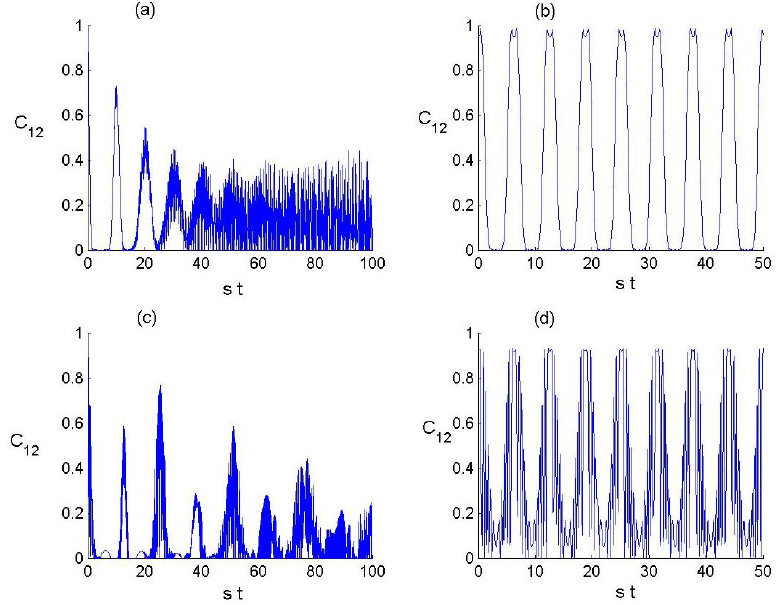
Figure 3. Time evolution of the TQS entanglement denoted by C 12 . Panels ( a , b ) correspond to the case of absence of the PDP effect (i.e., λ = 0 ) for constant ( D ( t ) = s ) and t-dc ( D ( t ) = s sin ( t )) , respectively. Panels ( c , d ) are, respectively, the same as ( a , b ) but in the presence of the PDP effect with λ =